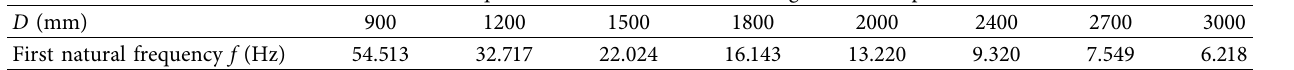
Figure 6: Constraints on the rotor. Table 6: First natural frequencies for the various rotor lengths without